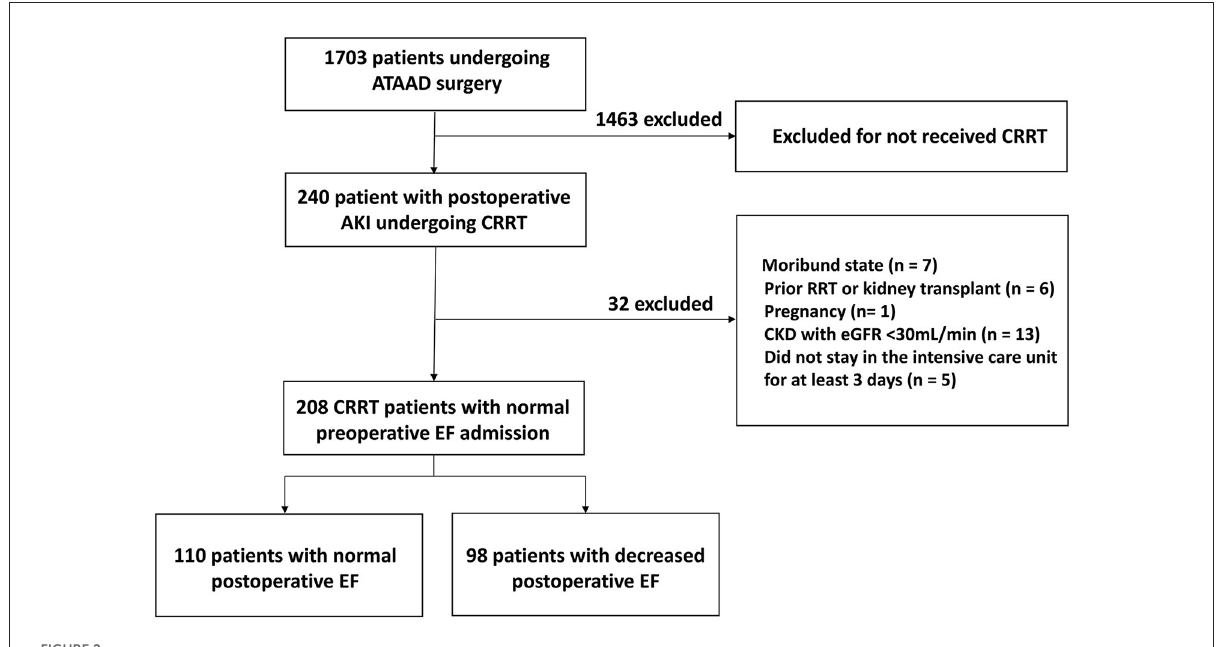
FIGURE2 The study